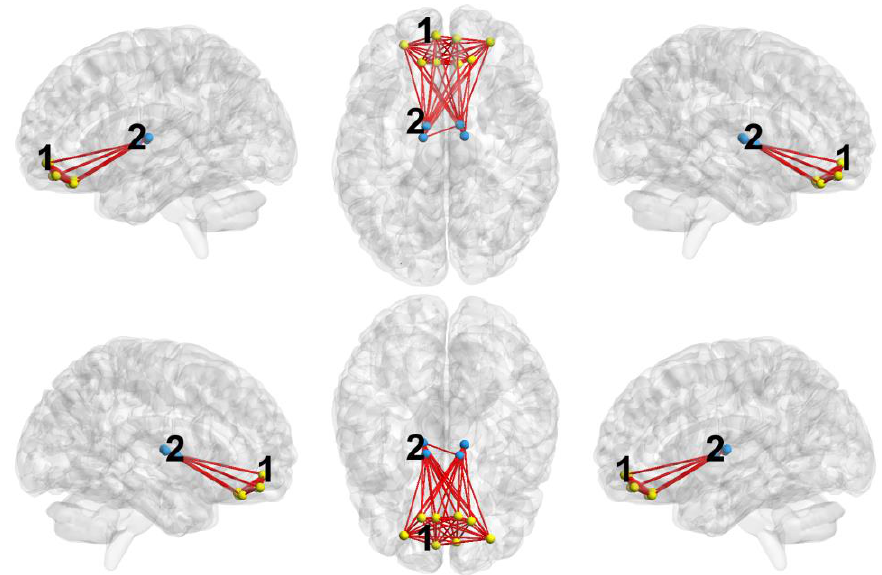
Figure 3. Connected graph obtained for the significant negative clusters (MDE > Control) of the considered network measures. Dots correspond to the nodes of the clusters and lines correspond to the significant connections between the nodes. Numbers denote approximate positions of the clusters (see Table 3). Yellow clusters are similar for all considered network measures and blue clusters are unique for eigenvector